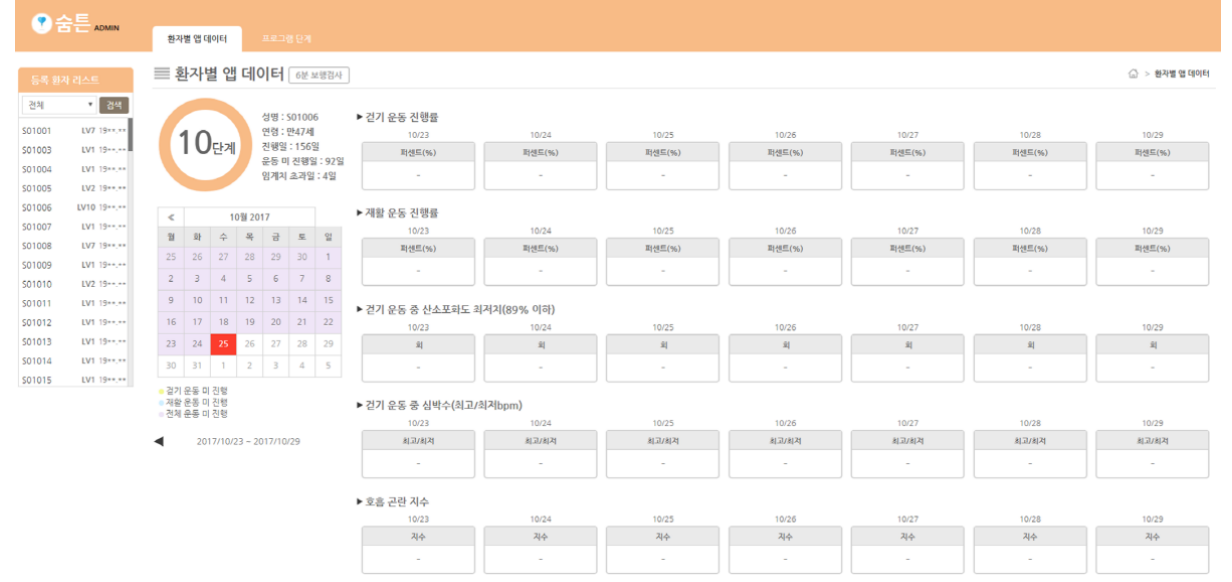
Figure 4. Patient health data screen showing detailed information about exercise and health measurements for a fictional